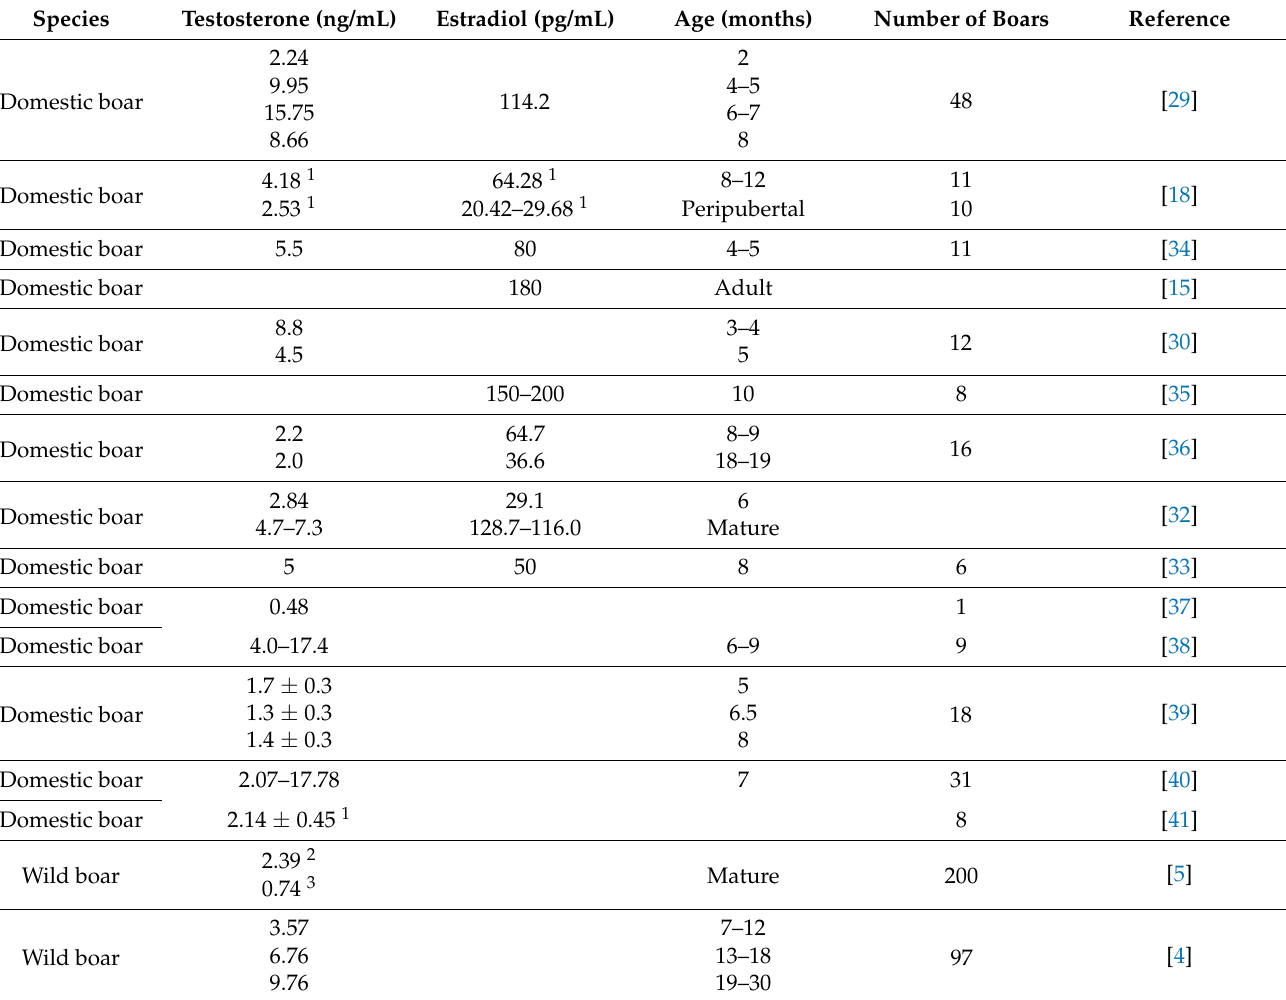
Table 2. Mean concentrations of T and E2 available in the open access literature for the domestic pig and the wild boar. Where present, information about the age and the respective number of sampled boars are provided as described in the